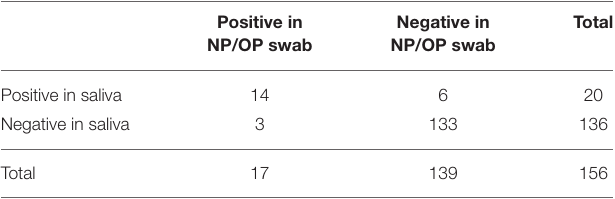
TABLE 2 | Concordance of the SARS-CoV-2 detection rate in saliva and NP/OP swab in children and